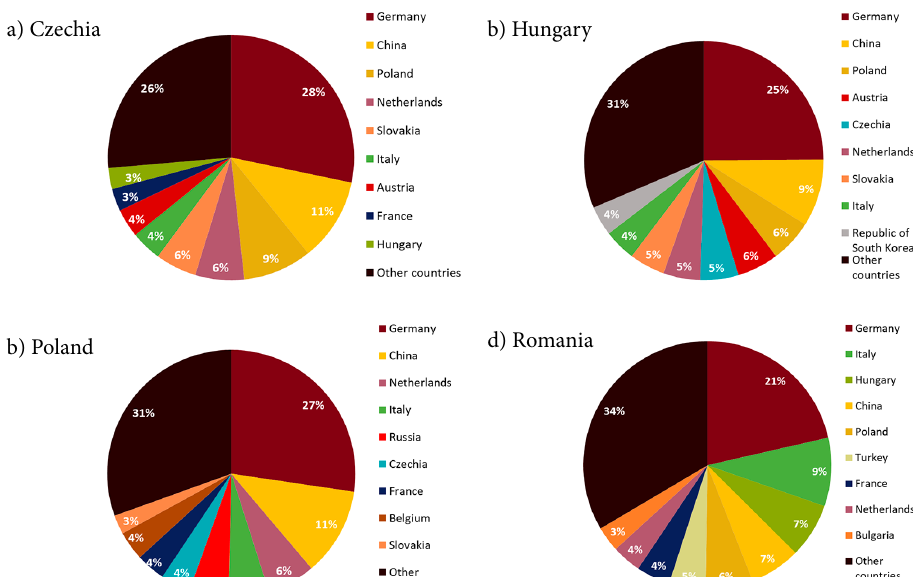
Figure A.2. Imports structure on main trade partners after the first 7 months of 2021 (12 months cumulated data) (source: Eurostat,